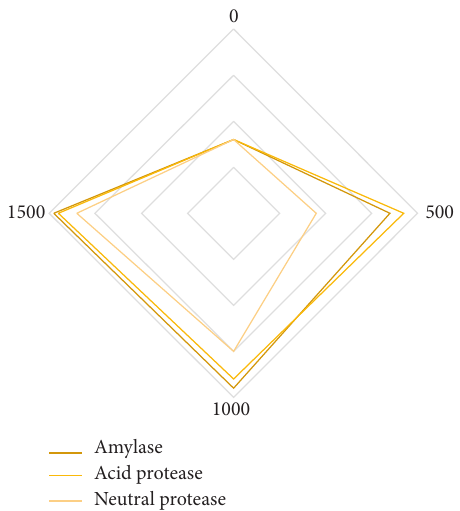
Figure 4: Single factor experiment.